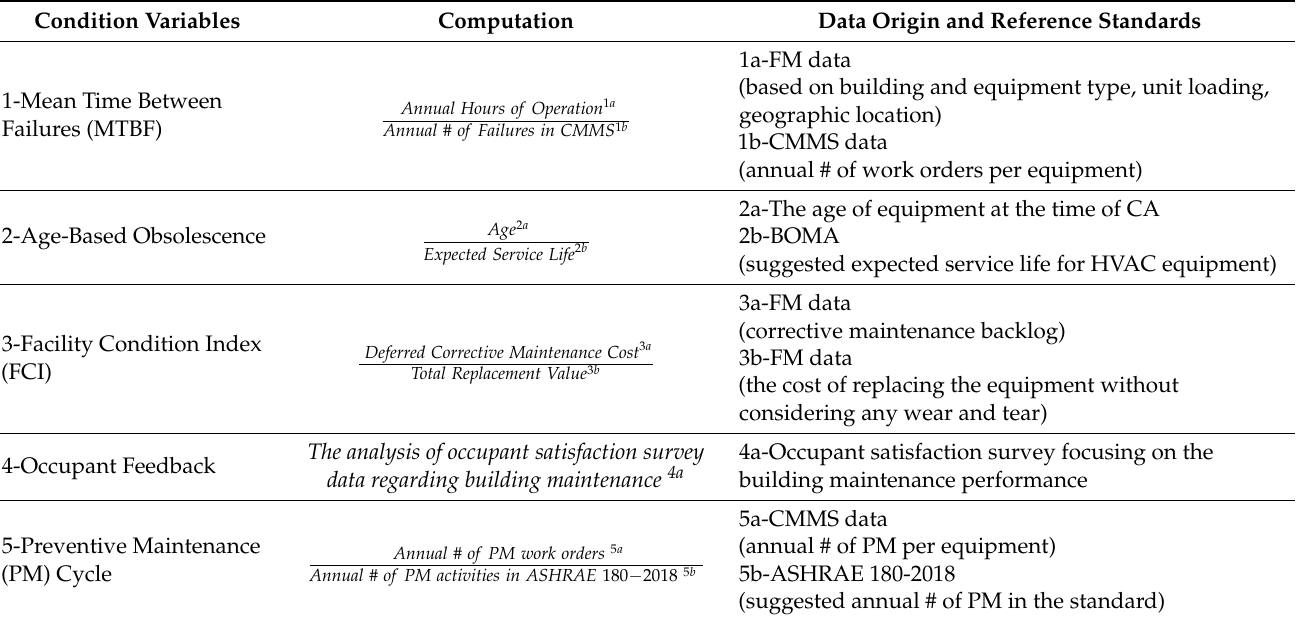
Table 2. Variables Considered in the Developed CA